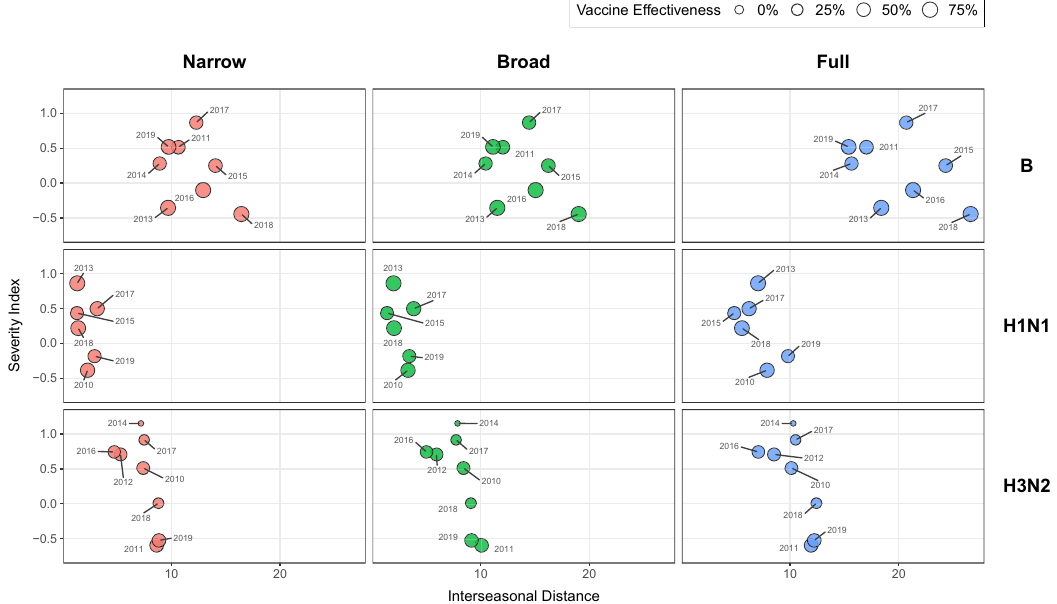
Figure 2. Relationship between the epidemiological severity (as measured by the Severity Index) and the genetic drift of influenza (as measured by the mean Hamming distance between a season and the previous one). Each row represents a type/subtype and each column a different definition of the antigenic distance. The label next to each point indicates the starting year of the epidemic season (e.g., 2014 for the 2014/2015 season). The size of the point is proportional to the vaccine effectiveness observed that year for a given